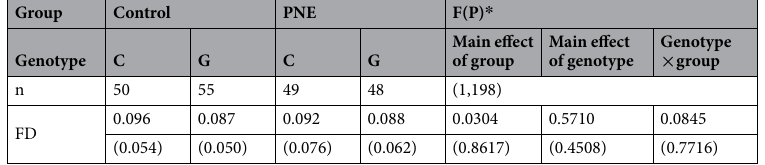
Table 2. Assessment of head motion using framewise displacement (FD). Abbreviations: PNE, primary nocturnal enuresis. The data are shown as the means (standard deviation). * F(P) is based on the analysis of variance with genotype and group as two